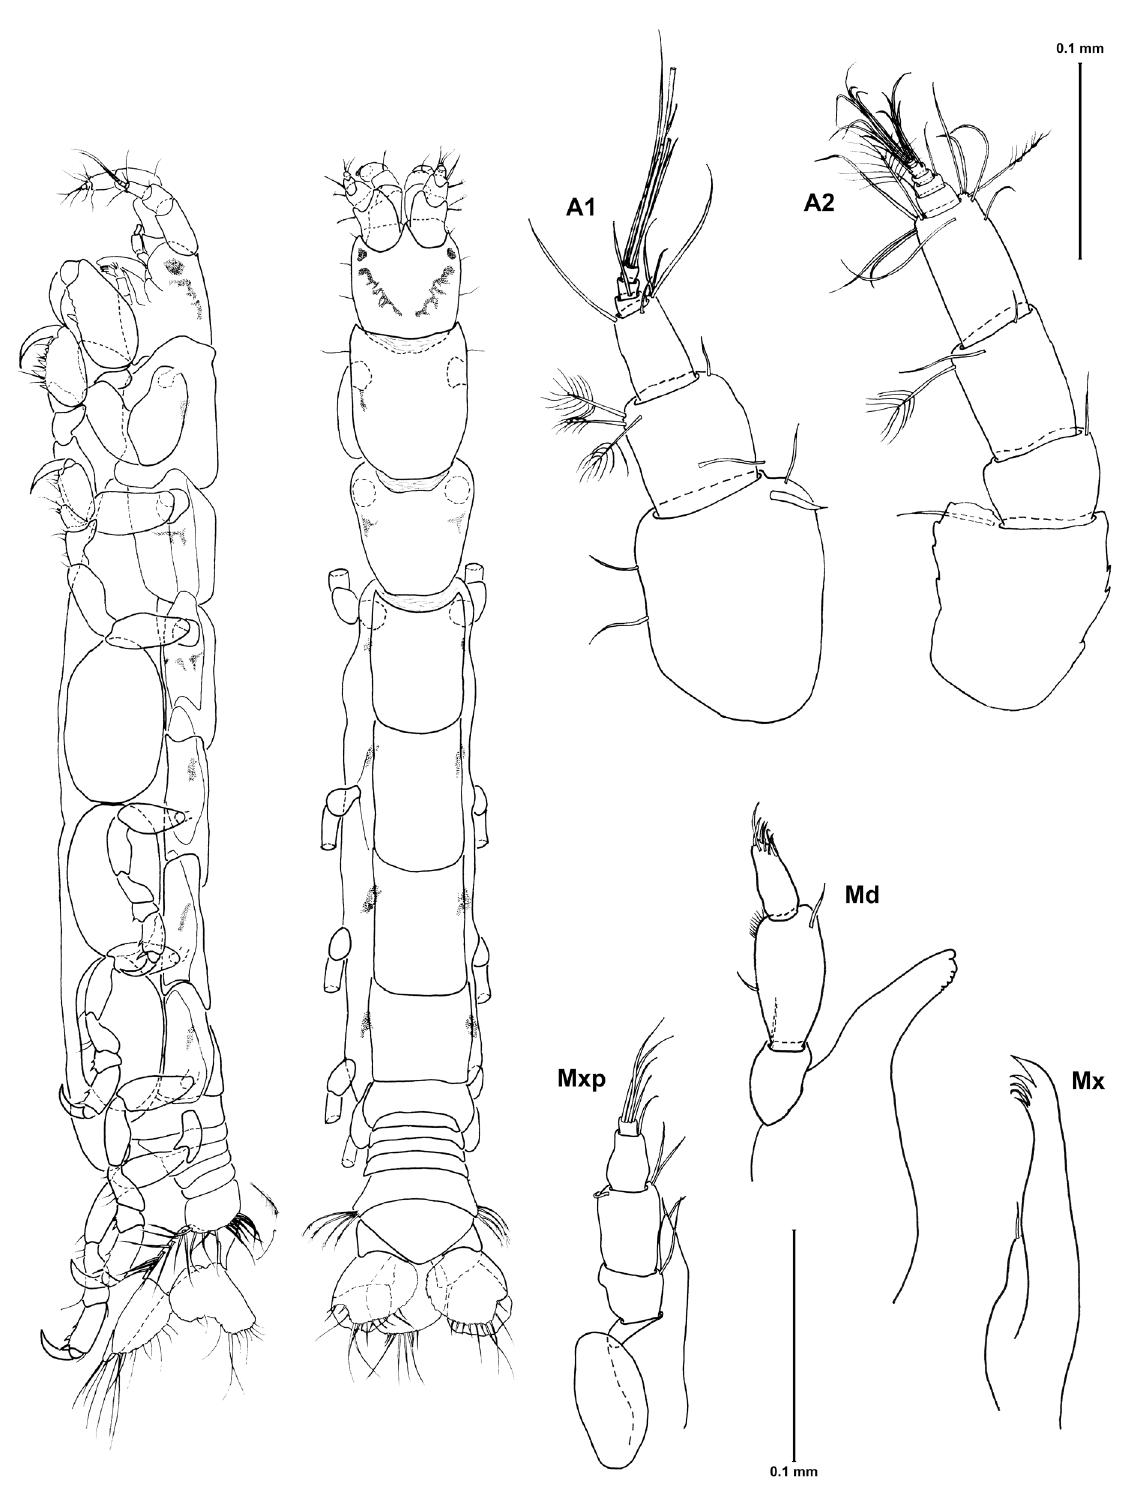
Fig. 18. Expanathura collaris (Kensley, 1979). Ovigerous ♀ from Bangka Island, in dorsal and lateral view (2.5 mm) (MZB Iso 106). Abbreviations: A1 = antenna 1; A2 = antenna 2; Md = mandible; Mx = maxilla, Mxp =